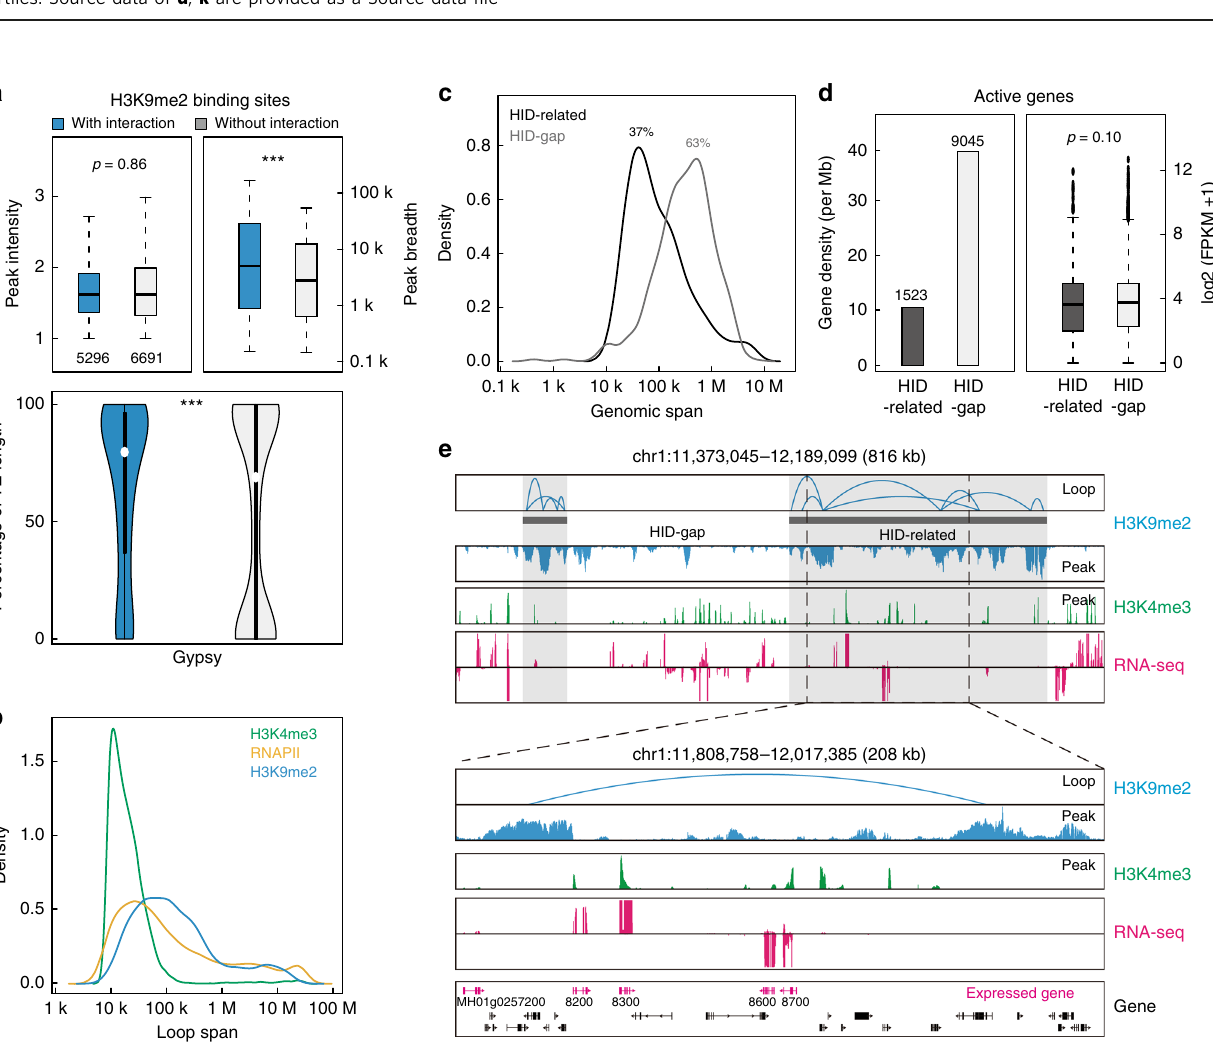
Fig. 2 Characterization of H3K4me3-associated promoter – promoter interactions. a Global view of H3K4me3-associated interactions and epigenetic and transcriptional features on chr4. Zoomed-in view of detailed loop and peak distributions at the indicated regions. b Chromatin models. The BP model, genes with binding sites that are not involved in chromatin interactions. The PPI model, genes with anchor sites involved in interactions. P promoter; solid curve, chromatin loop. c Pie chart for the percentage and number of genes engaged in H3K4me3-associated chromatin models. d Boxplot for intensities of H3K4me3 peaks (left) and expression levels of BP and anchor genes (right). *** p < 0.001 from Wilcoxon test. e Expression breadth of H3K4me3 anchor and BP genes. Random genes served as control. p < 2.2e − 16 from Kruskal – Wallis test. f Distribution of core and distributed genes that participated in PPI models. Core genes, present in more than 99% of 453 rice accessions; distributed genes, present in <99% of 453 rice accessions. g Contour plot of log- transformed FPKM values for H3K4me3 anchor gene pairs. h Histogram for co-expression analysis of H3K4me3 anchor gene pairs. The mean PCC of anchor gene pairs is much higher than that of both (A) randomly simulated gene pairs and (B) randomly selected H3K4me3-marked gene pairs which have the same physical distance with anchor gene pairs. i H3K4me3-associated PPI network from chromosome 3. The size of the circles is proportional to the degree (connection frequency) of the genes (as nodes). The redder color indicates higher gene expression. j A screenshot of a H3K4me3-associated cluster in dotted line box area of h . k Boxplot shows the positive relationship of the degrees of genes with transcriptional activity. Gene numbers in each category are given. l Co-expression analysis of genes in H3K4me3-associated subnetworks. The PCC of subnetworks are calculated. Random, randomly selected gene pairs. Actual, all H3K4me3 anchor gene pairs. *** p < 0.001 from Wilcoxon test. Boxplots in d , k , l show the median, and third and fi rst quartiles. Source data of d , k are provided as a Source data fi le